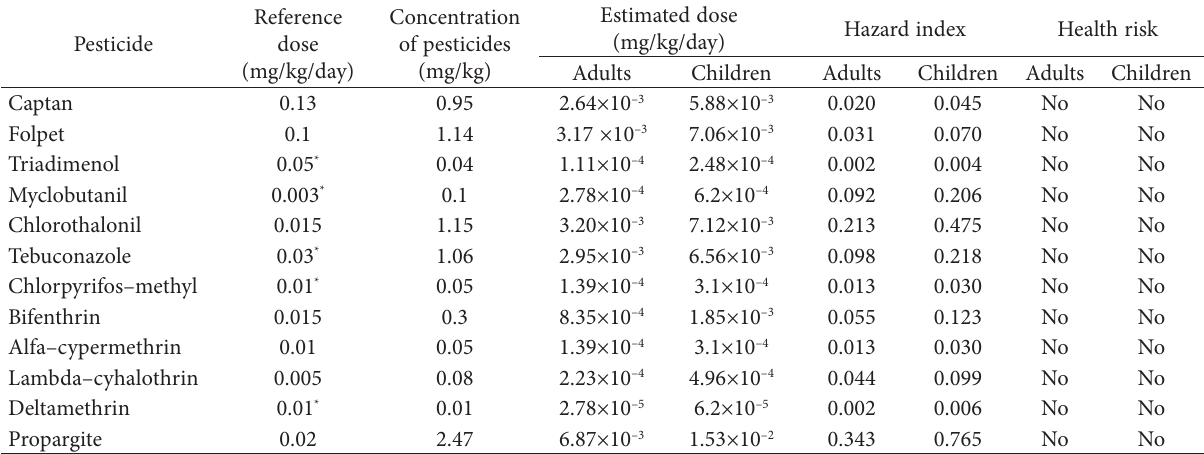
Table 4. Health risk estimation associated with pesticide residues in apples, at harvest